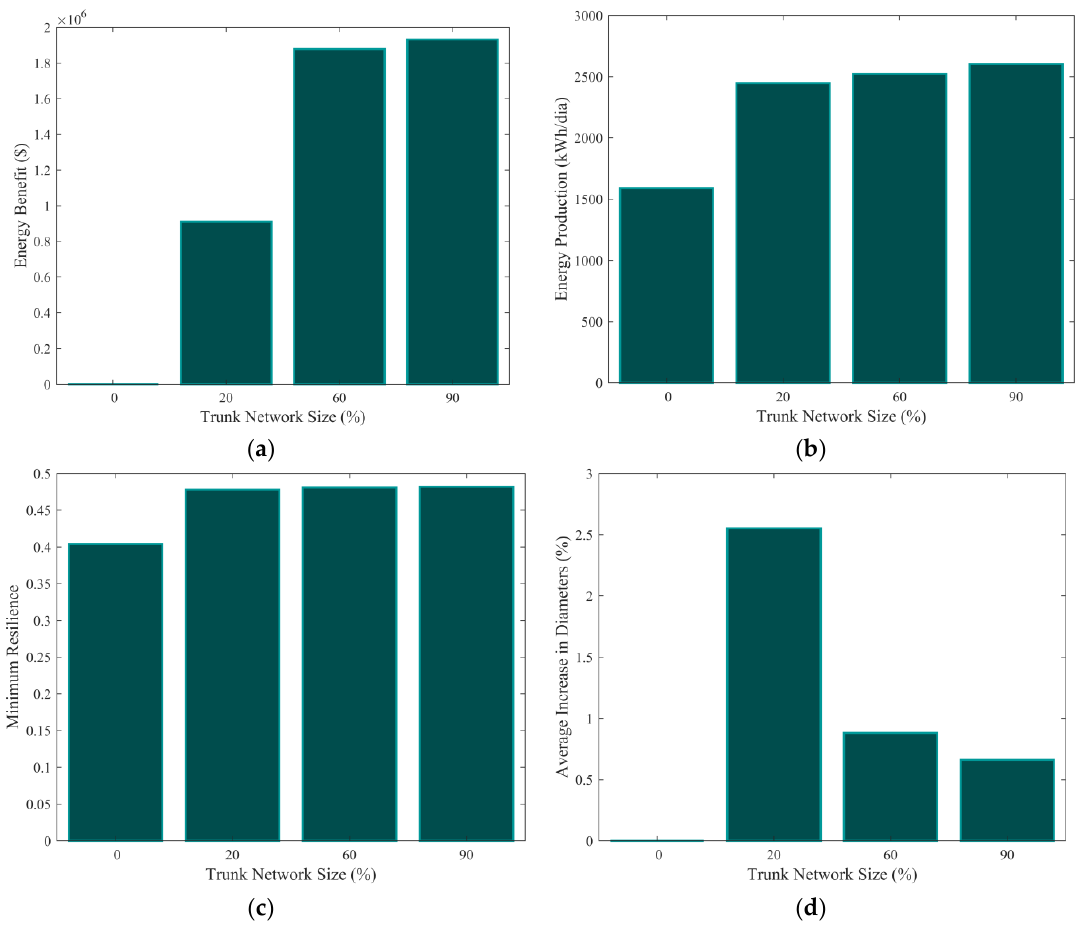
Figure 14. Results of TN rehabilitation for the Balerma irrigation network: ( a ) Energy benefit; ( b ) Energy produced; ( c ) Minimum resilience; and, ( d ) Average increase in pipes diameters.